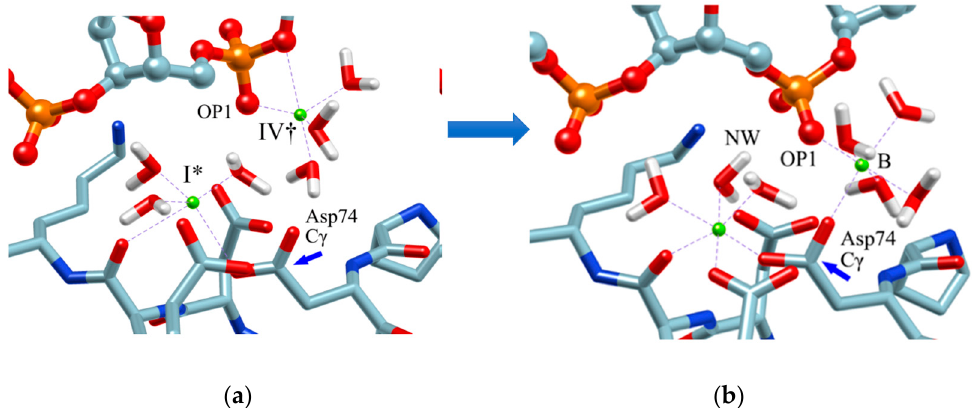
Figure 8. MD simulation: ( a ) initial structure, ( b ) structure after 1 nanosecond (equilibrium structure). (The figure is reprinted from Ref. [69]. Copyright (2018) American Chemical Society.)